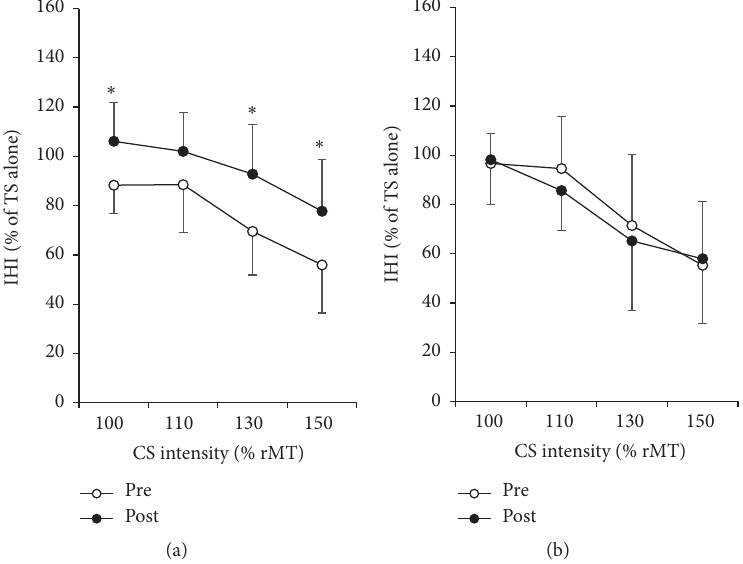
Figure 2: Interhemispheric inhibition (IHI) curves. IHI curves ( 𝑁 = 10 ) show inhibition effect from the M1 in the right hemisphere (where the conditioning stimulus (CS) was delivered) to the M1 in the left hemisphere (where the testing stimulus (TS) was delivered). The abscissa indicatestheCSintensitiesexpressedasafractionofrMT.TheordinateindicatestheamplitudeofconditionedMEPfromtheleftM1expressed as a percentage of the MEPs from TS alone. Higher values represent lower inhibition from the right M1 to the left M1. Preintervention ( I ); postintervention ( e ). After the intervention, significantly lower inhibitions from CS to TS were observed from the treatment of acupuncture (a) but not the control (b). ∗ 𝑃 < 0.0125 (Bonferroni’s post hoc